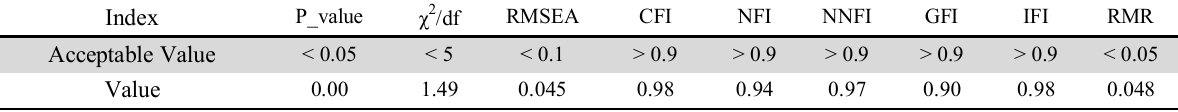
Fit indexes of model 2